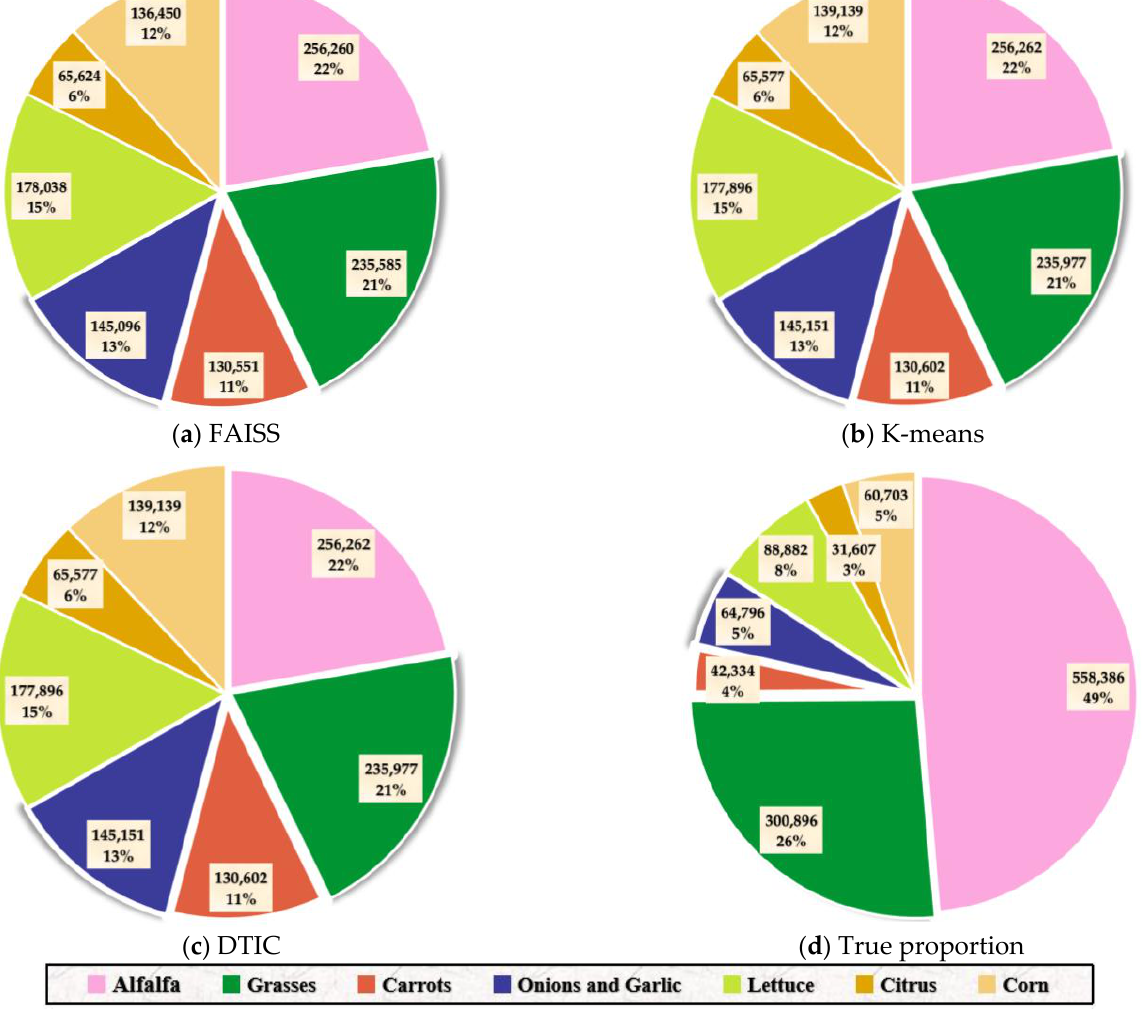
Figure 13. Quantity and percentage of each class on the Imperial Dataset using different methods implemented with averaged initial cluster centers. ( a ) FAISS; ( b ) K-means; ( c ) DTIC; ( d ) true proportion.